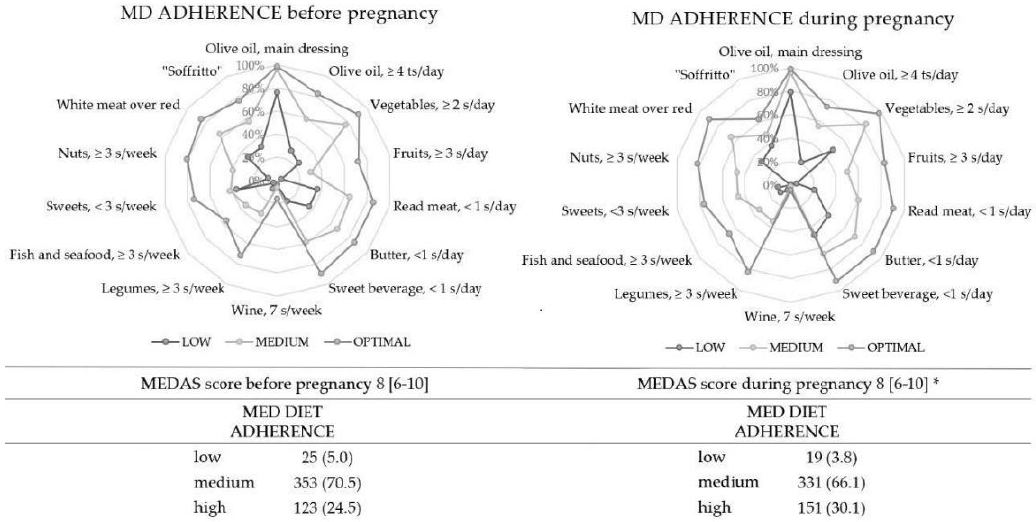
Figure 1. MEDAS items compliance following high, medium, and low adherence to MD before and during pregnancy. The radar graphic highlights every item value along the axis that starts in the center of the graph (compliance = 100%). Values are expressed as the percentage of the population that follows every recommendation. Vegetables daily serving: 1 medium portion = 200 g. Fruit daily serving: 1 serving = 100 – 150 g portion. Red meat/hamburgers/other meat daily serving: 1 medium portion = 100 – 150 g. Butter, margarine, or cream daily serving: 1 medium portion = 12 g. Sweet or sweetened carbonated drinks daily serving: 1 medium portion = 200 mL. Wine daily serving: 1 medium portion = 125 mL. Legumes weekly serving: 1 portion = 150 g. Fish daily serving: 1 medium portion = 100 – 150 g. Seafood daily serving: 1 medium portion = 200 g. Nuts weekly serving: 1 portion of dairy product = 30 g. MD, Mediterranean diet; s, serving; ts, tablespoon. * The Shapiro – Wilk test was performed to evaluate the variable distribution. Variables are considered non-normally distributed for p < 0.05.